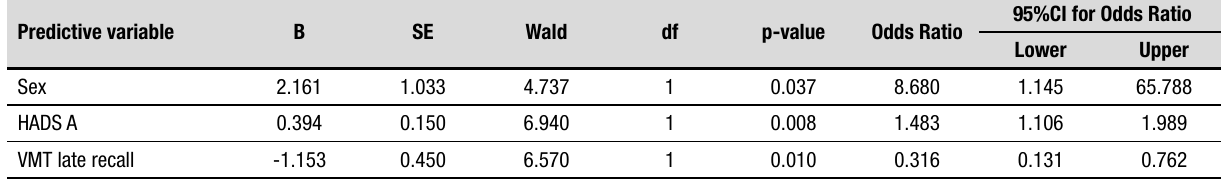
Table 3. Final logistic regression model to predict stroke (step 4).